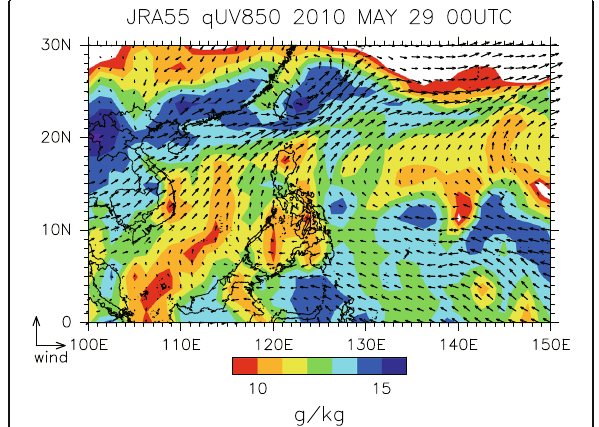
Fig. 13 Horizontal structure of moisture (shading; g/kg) and wind (vector) at 850 hPa on May 29, 2010. Unit vectors represent 25.0